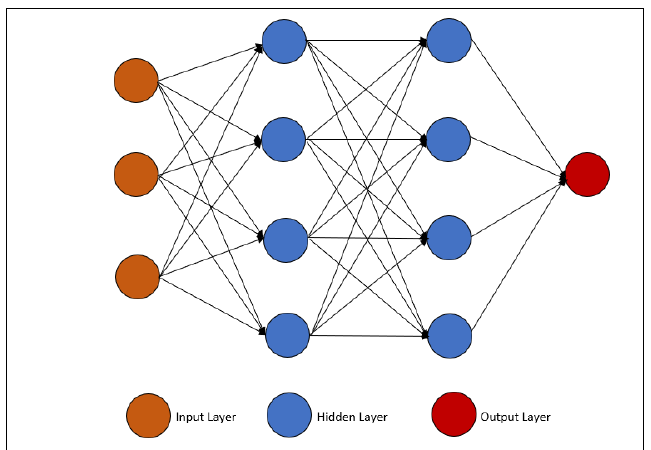
Figure 8. ANN architecture which consists of three-layer : Input Layer (orange color), Hidden Layer (blue color) and Output Layer (red